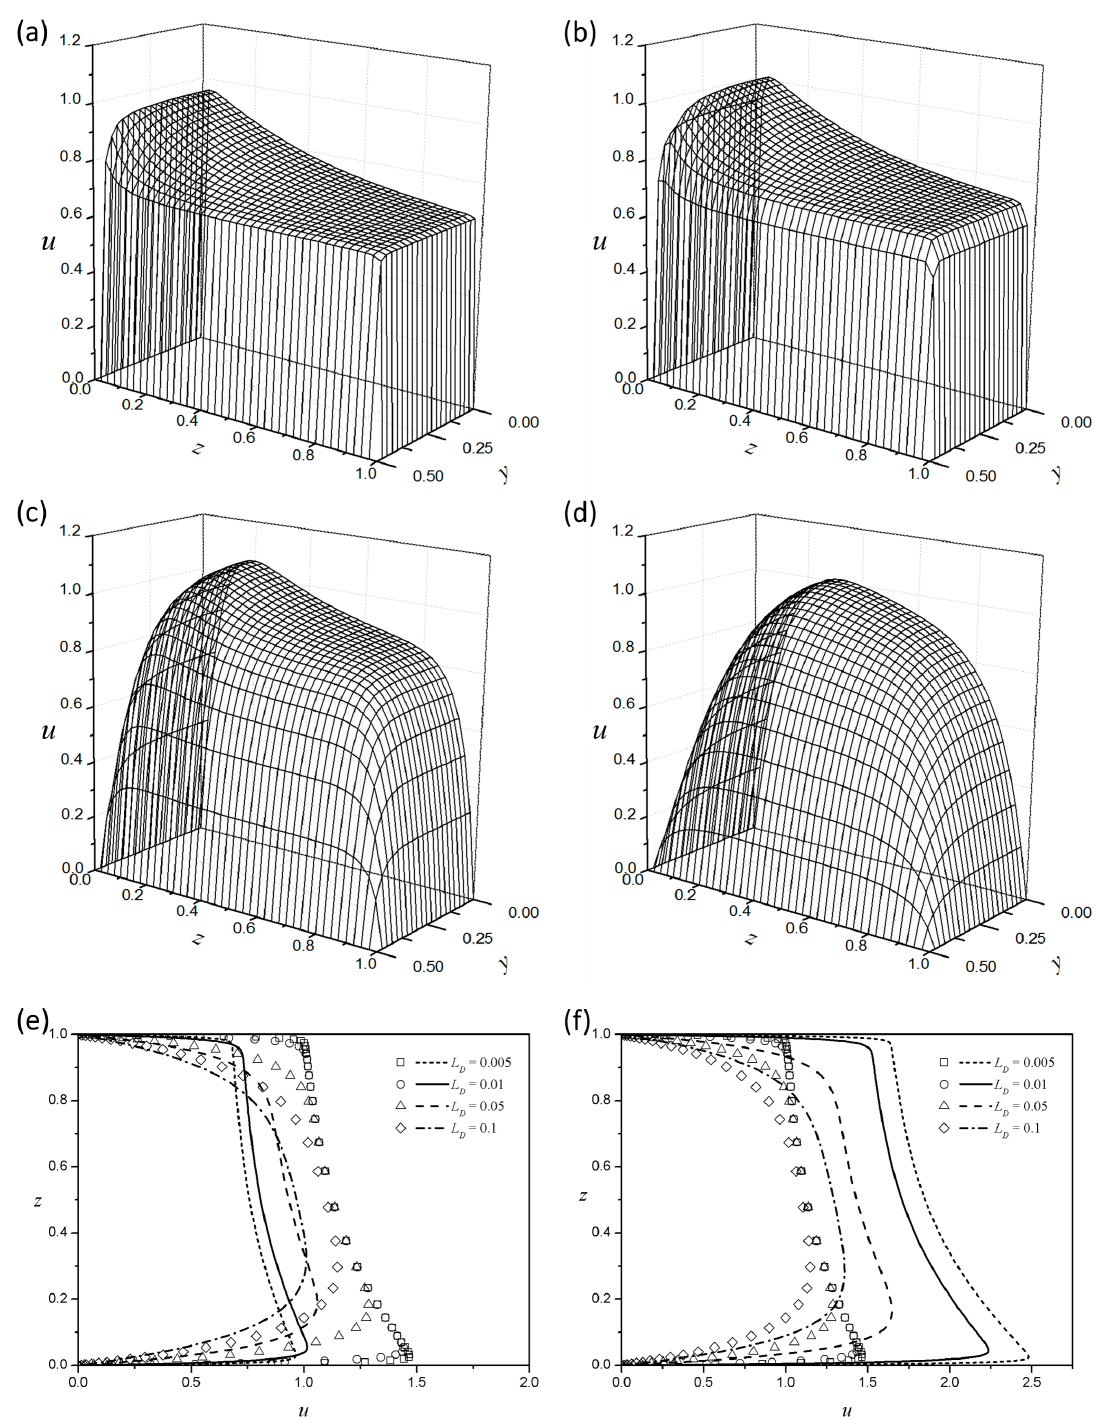
and : Figure 7. Velocity distribution at different values of Debye length for Figure 7. Velocity distribution at different values of Debye length for n = 1.1 and Z R = 1.5: ( a ) ; ( b ) ; ( c ) ; and ( d ) . Velocity profiles along the centerline ( a ) L D = 0.005; ( b ) L D = 0.01; ( c ) L D = 0.05; and ( d ) L D = 0.1. Velocity profiles along the 𝑛𝑛 = 1.1 𝑍𝑍 𝑅𝑅 = 1.5 and . Symbols, Newtonian fluid: ( e ) shear- according to different Debye lengths for centerline according to different Debye lengths for Z R = 1.5 and A R = 1. Symbols, Newtonian 𝐿𝐿 𝐷𝐷 = 0.005 𝐿𝐿 𝐷𝐷 = 0.01 𝐿𝐿 𝐷𝐷 = 0.05 𝐿𝐿 𝐷𝐷 = 0.1 thinning and ( f ) shear-thickening fluids. fluid: ( e ) shear-thinning ( n = 0.9 ) and ( f ) shear-thickening ( n = 1.1 ) 𝐴𝐴 𝑅𝑅 = 1 𝑍𝑍 𝑅𝑅 = 1.5 ( 𝑛𝑛 = 0.9) ( 𝑛𝑛 = 1.1)